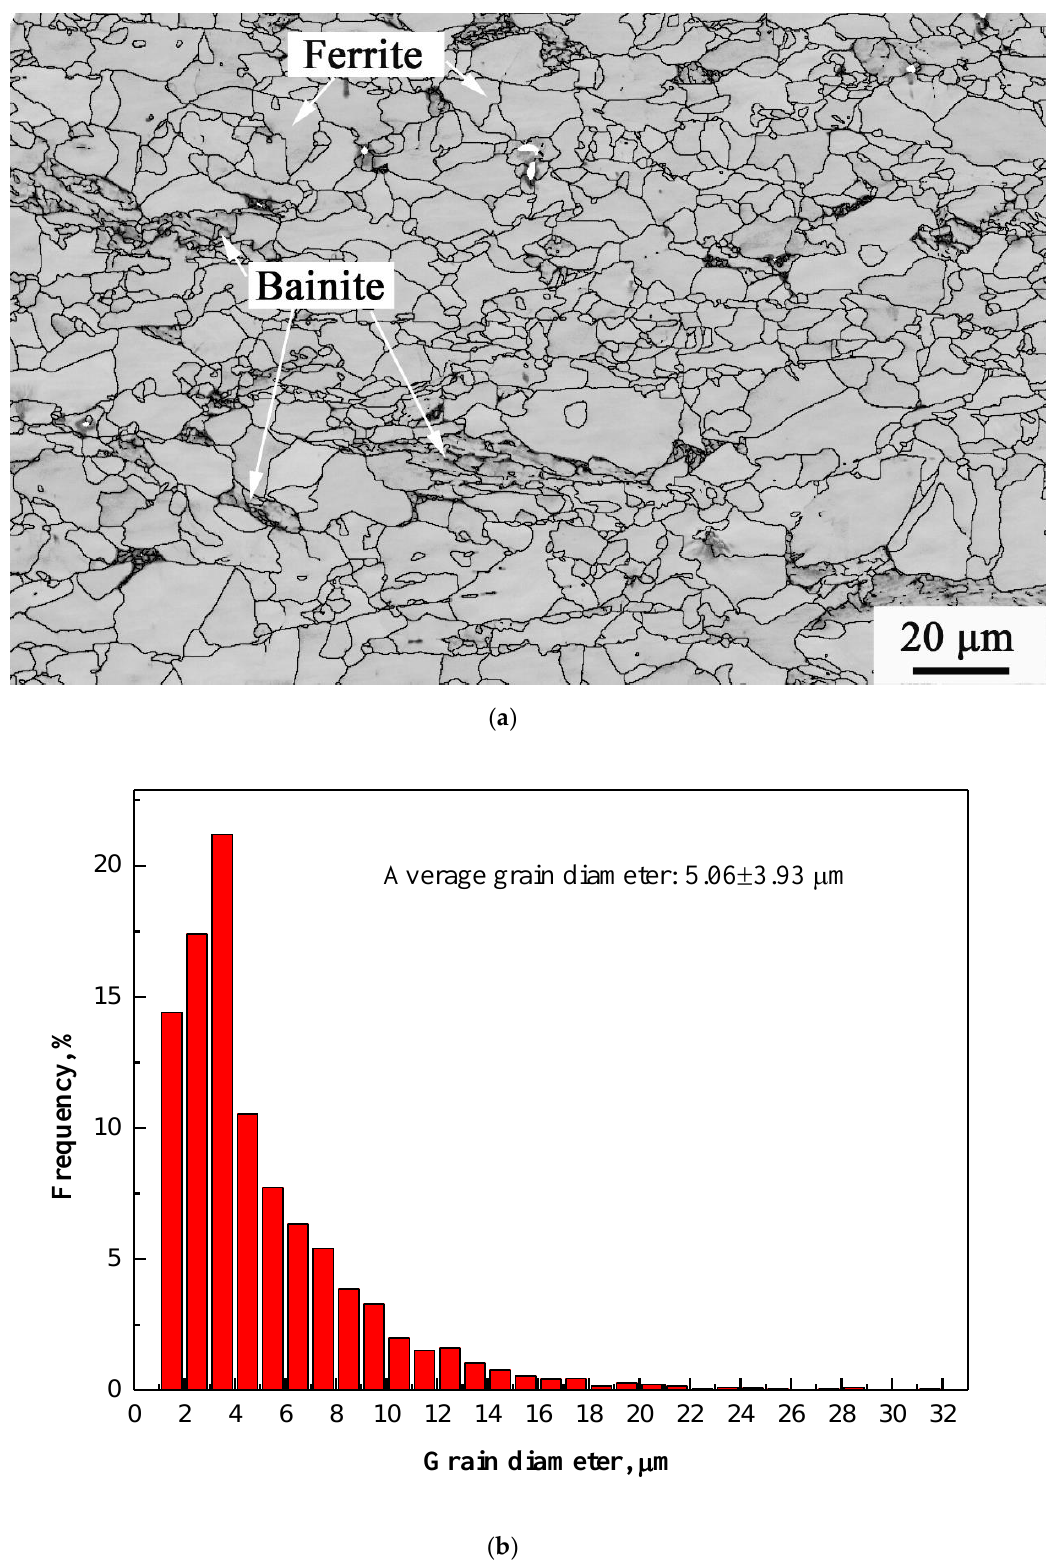
Figure 2. ( a ) EBSD image showing ferrite grains and bainitic microstructure. ( b ) The ferrite grain size distribution profile obtained from the EBSD image using HKL CHANNEL 5 flamenco software after getting rid of bainite manually.